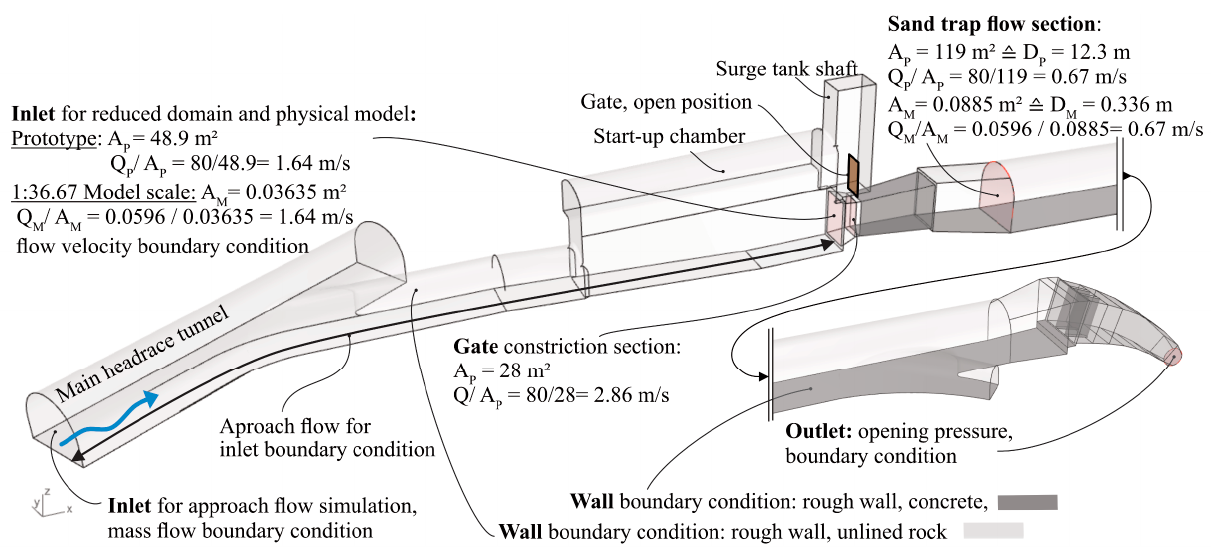
Figure 3. Definitions of flow velocities of characteristic flow sections for prototype and model scale. Subscript P denotes prototype scale, and subscript M denotes model scale.